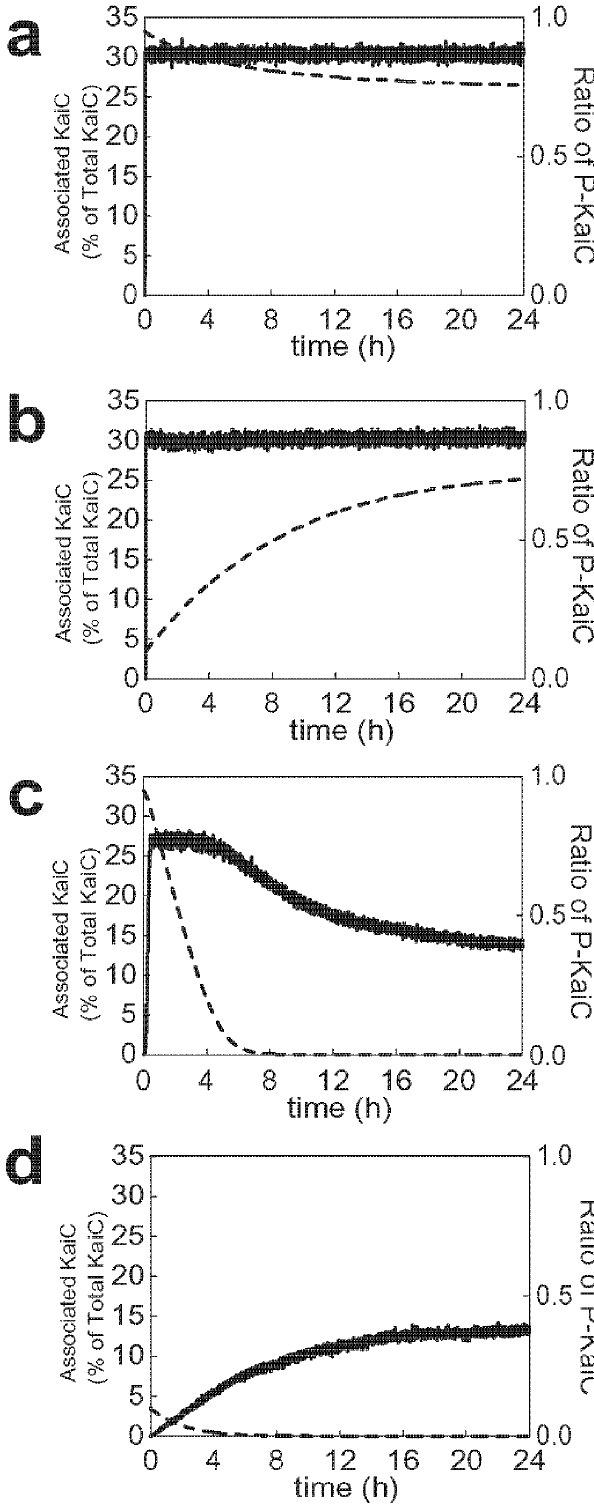
Figure 7. Interplay of the KaiC-KaiA and KaiC-KaiB association and the phosphorylation level of KaiC. The amount of associated KaiC is shown in solid lines as percentage of the total number of KaiC hexamers, whereas the phosphorylation level, p ( t ), is shown in dashed lines. (a) KaiC with p (0) , 95% is incubated with KaiA, (b) KaiC with p (0) , 5% is incubated with KaiA, (c) KaiC with p (0) , 95% is incubated with KaiB, and (d) KaiC with p (0) , 5% is incubated with KaiB.